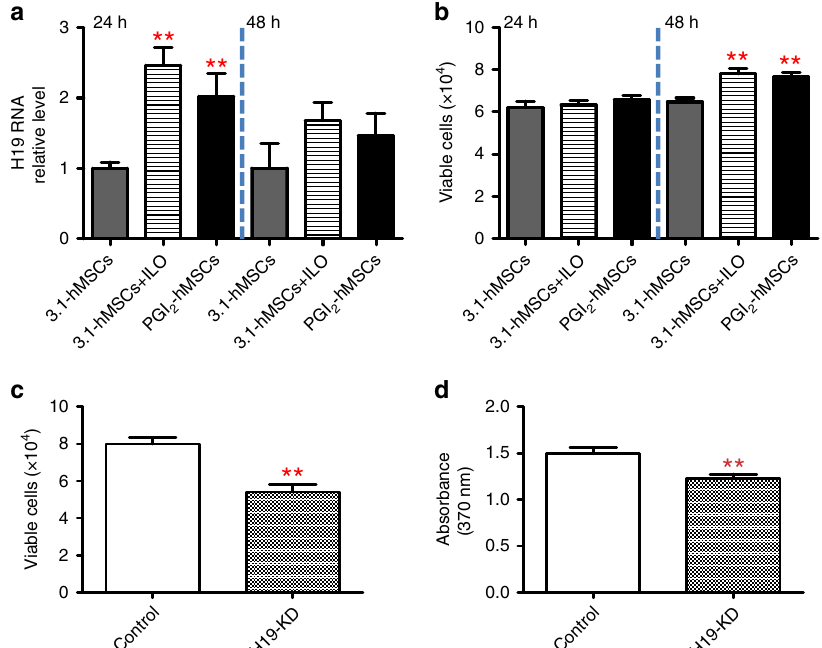
Figure 7 | H19 lncRNA promoted host myoblasts survival and proliferation under hypoxia (1.5% O 2 ). ( a ) Primary myoblasts co-cultured with PGI 2 -hMSCs or with 3.1-hMSCs þ ILO for 24h showed a significant increase in H19 lncRNA levels as compared with those co-cultured with 3.1-hMSCs. The increase in H19 lncRNA levels was transient; at 48h, levels were comparable among all the groups. ( b ) No differences were seen in the total number of viable cells among myoblasts co-cultured with PGI 2 -hMSCs, 3.1-hMSCs þ ILO or 3.1-hMSCs for 24h. However, by 48h, the number of viable myoblasts was significantly higher when cells were co-cultured with PGI 2 -hMSCs or 3.1-hMSCs þ ILO than with 3.1-hMSCs. ( c ) H19 silencing reduced the paracrine effects of PGI 2 -hMSCs on myoblast survival. The total number of viable cells was significantly reduced in myoblasts with H19 deficiency (H19 KD) that were co-cultured with PGI 2 -hMSCs for 48h as compared with control myoblasts co-cultured with PGI 2 -hMSCs in parallel. ( d ) The paracrine effects of PGI 2 -hMSCs on myoblast proliferation were also impaired with H19 silencing. Myoblasts with H19 deficiency that were co-cultured with PGI 2 -hMSCs for 48h showed a significant reduction in cell proliferation as compared with control myoblasts co-cultured in parallel with PGI 2 -hMSCs. ** P o 0.01. Statistical significance was determined by one-way ANOVA with Newman–Keuls post hoc test ( a , b ) and a two-tailed t -test ( c , d ). Data are shown as mean ± s.e.m. from three to four replicates and are representative of three independent experiments with similar